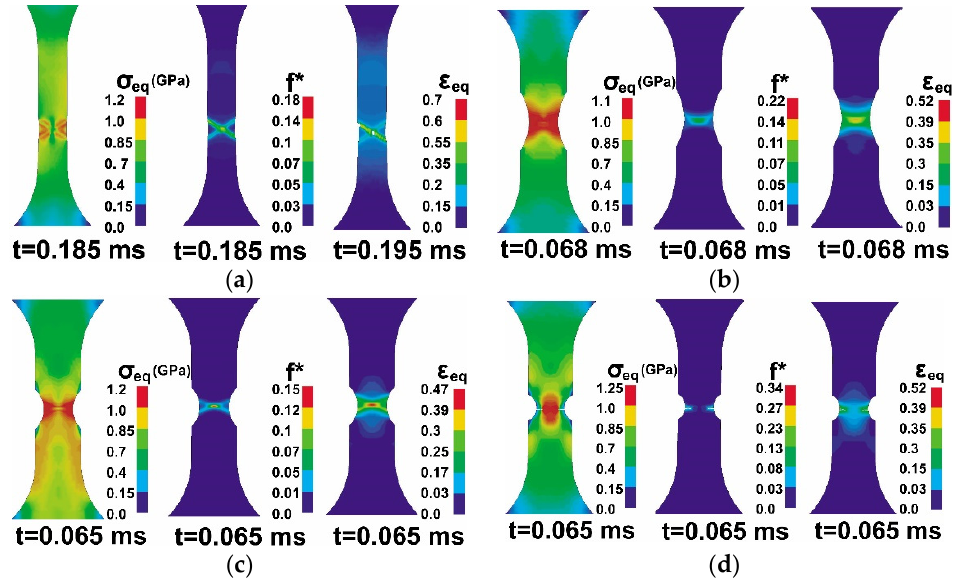
Figure 15. ( a – d ) Fields of calculated effective stress, damage parameter, and effective plastic strain in the specimen of Ti ‐ 5Al ‐ 2.5Sn under tension at 20 m/s.